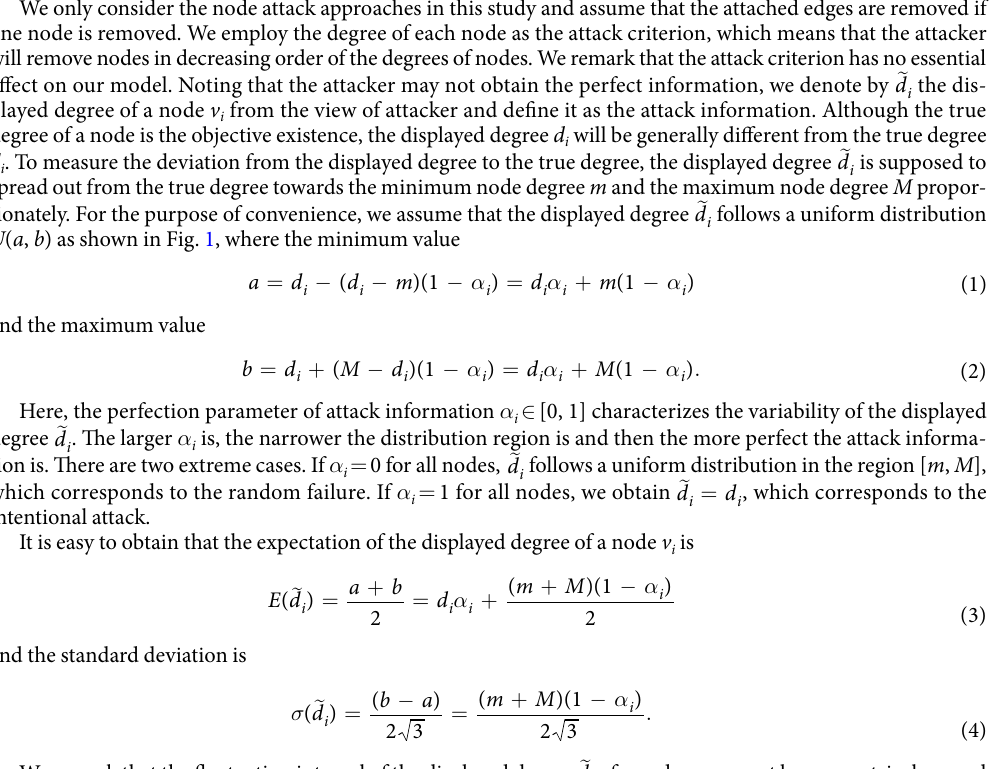
Figure 1. Illustration of the mathematical model of attack information.  f d ( ) of the displayed degree  d . The information perfection parameter α i characterizes the variability of the displayed i degree  d i